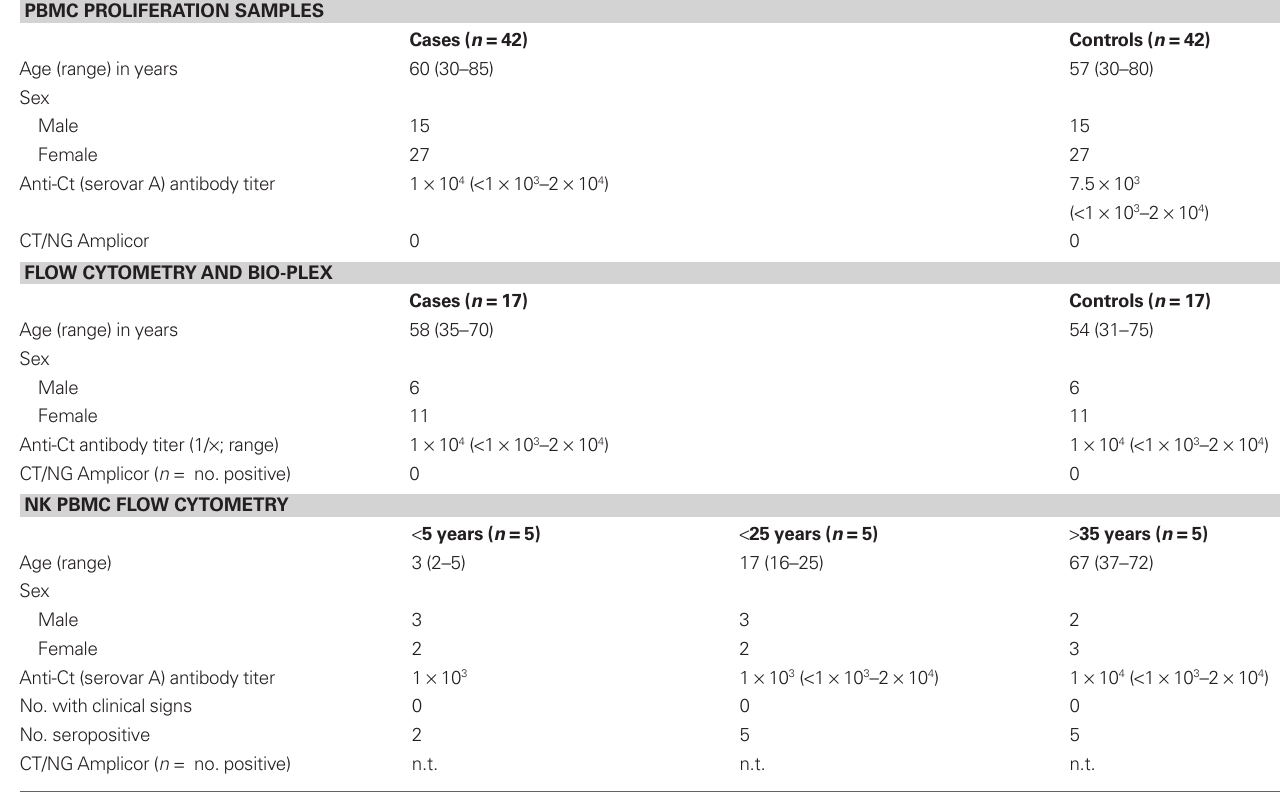
Table 1 | Study participant demographics and Ct antibody